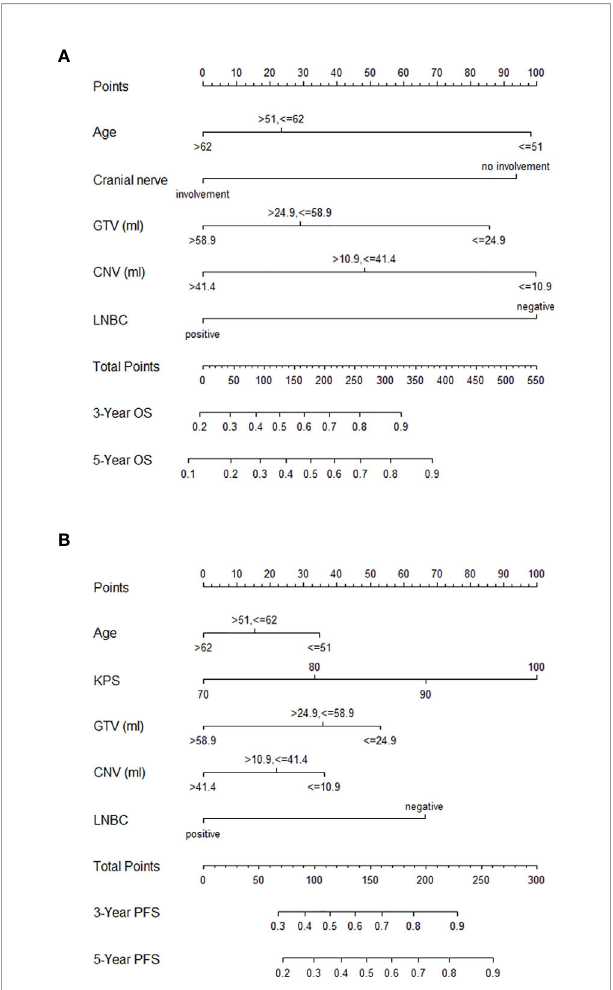
FIGURE 3 | Nomograms for NPC patients with CCRT for OS (A) and PFS (B) . NPC, nasopharyngeal carcinoma; CCRT, concurrent chemoradiotherapy; OS, overall survival; PFS, progression-free survival; GTV, gross tumor volume; CNV, cervical nodal volume; LNBC, positive cervical lymph node laterality below the caudal border of the cricoid cartilage; KPS, Karnofsky performance status.